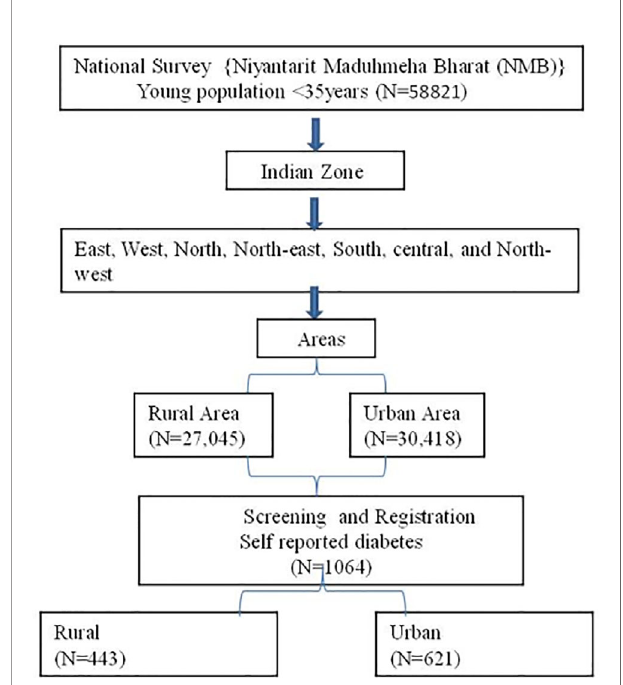
FIGURE 1 | Population sampling strategy of nationwide NMB